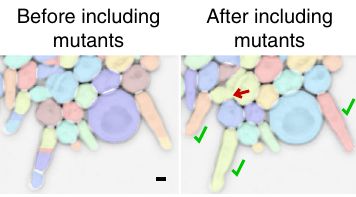
Fig. 6 Adaptability of the CNN. clb1-6 Δ mutants were either excluded (left) or included (right) in the training set for the CNN, which was then tested on an image of clb1-6 Δ cells from a later time point with even longer fi laments, shown here. Note that the color of each cell is dependent on the internal numbering and therefore arbitrary. However, there are no fragmented fi lamentous cells on the right (green check marks) although there are segmentation errors when the strangely shaped cells are crowded (red arrow). Phase contrast image inverted for better visualization. Scale bar: 2 μ